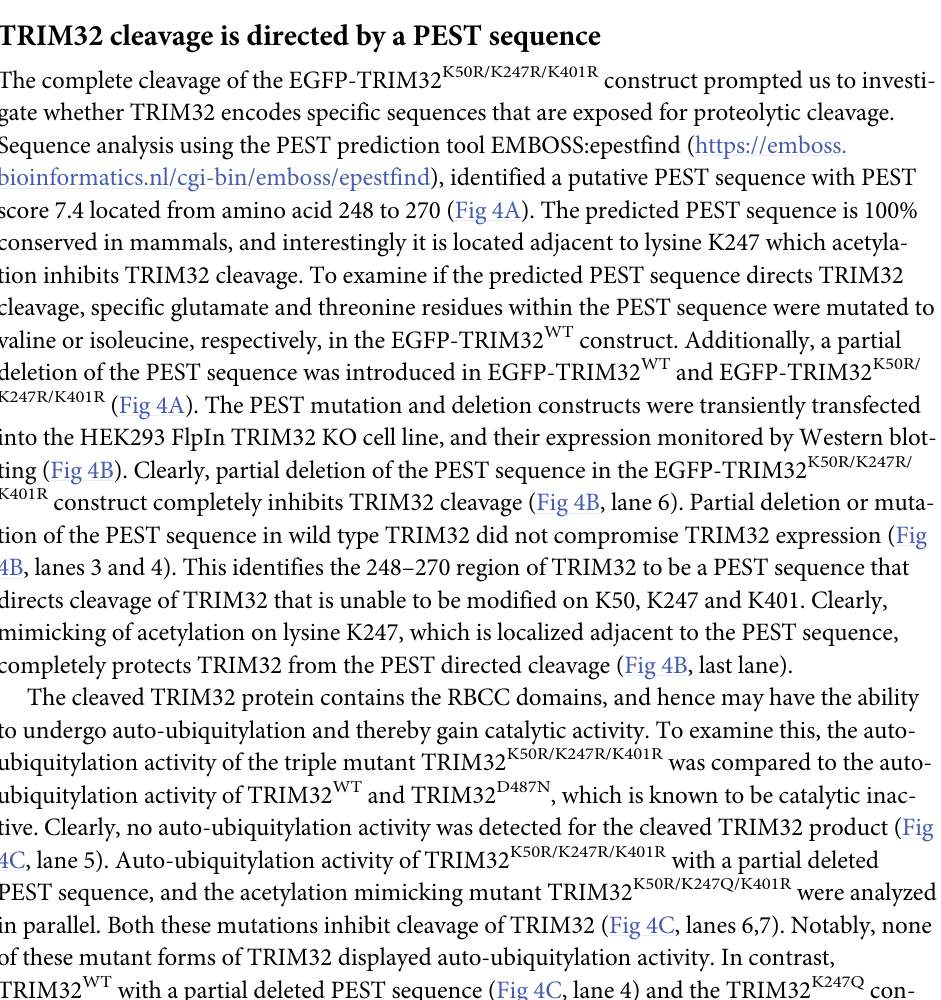
Fig 3. PTMs on TRIM32 K50 , TRIM32 K247 , TRIM32 K401 regulate autophagic degradation of TRIM32. (A) Confocal images of mCherry-EYFP-TRIM32 WT , mCherry-EYFP-TRIM32 K247R/K401R , mCherry-EYFP-TRIM32 K247Q , mCherry- EYFP-TRIM32 K50R/K247Q/K401R or mCherry-EYFP-TRIM32 K50R/K247R/K401R transiently expressed in HEK293 FlpIn TRIM32 KO cells and exposed to normal or starved conditions. Scale bars: 10 μ M. (B) The graphs represent the number of cells with RedOnly dots in the mCherry-EYFP-TRIM32 transfected cells shown with representative images in A. The graphs represent the average of three independent experiments with s.d. (n > 20 cells). �� P < 0.005; ��� P < 0.0005 (Student’s t -test).